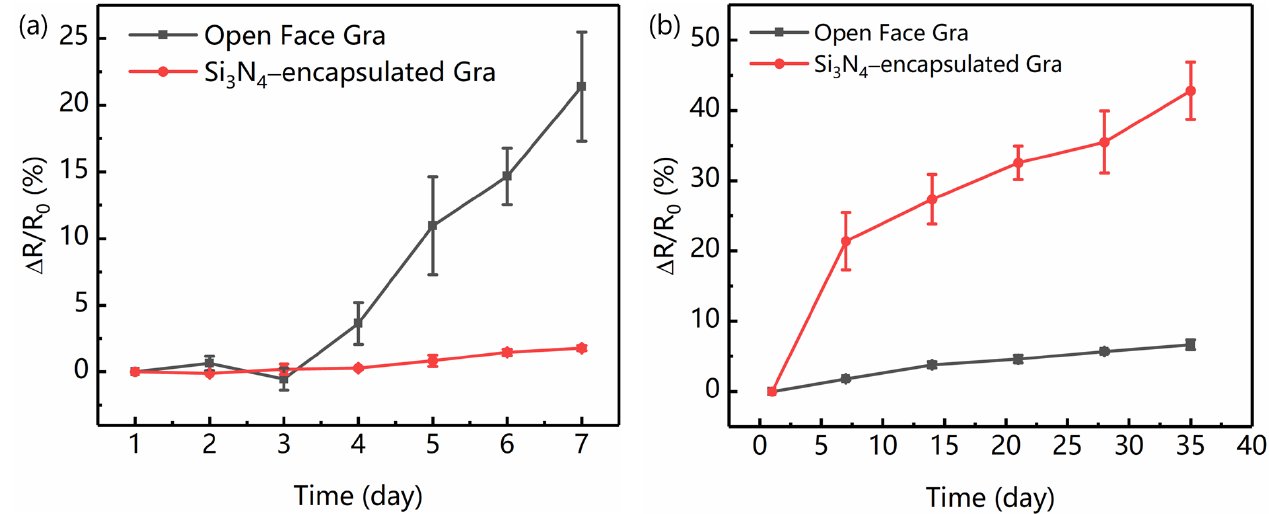
Figure 4. Stability of graphene sensing element with and without the top Si 3 N 4 layer: ( a ) 7 and ( b ) 35 days later.